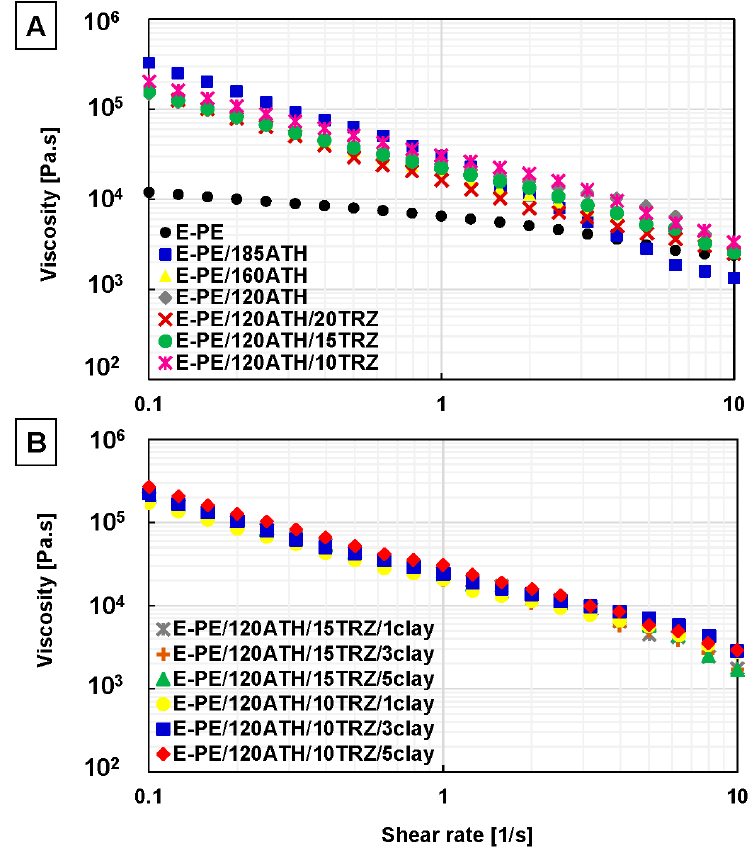
Figure 4. Simple shear viscosity as a function of shear rate for: ( A ) E-PE blend, E-PE/ATH and E-PE/120ATH/TRZ composites using ATH and TRZ at different content, and ( B ) E-PE/120ATH/15TRZ/clay and E-PE/120ATH/10TRZ/clay composites varying clay content.